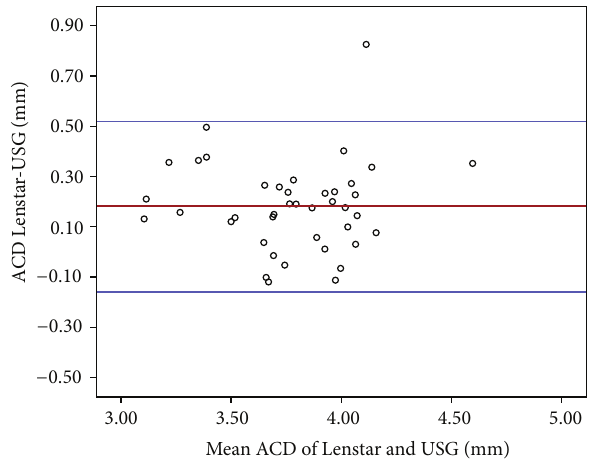
Figure 2: The Bland-Altman plot (left) showing differences in average anterior chamber depth (ACD) measurement of the devices. The bold horizontal line demonstrates the mean difference between the devices. The dotted lines above and below represent the 95% limits of agreement interval.